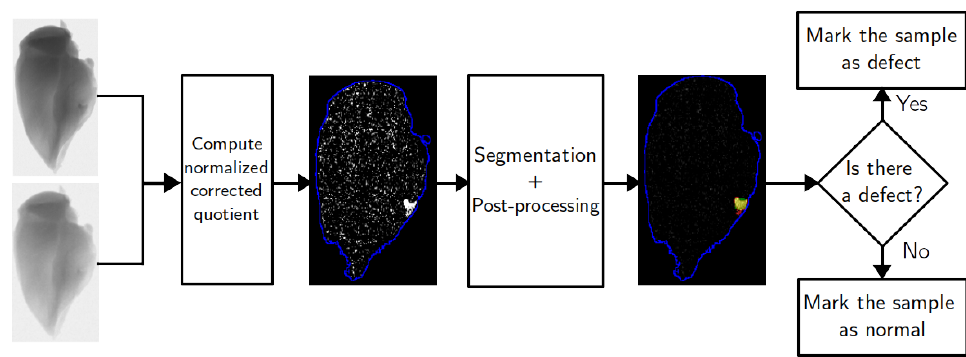
Figure 1. Diagram of the foreign object inspection procedure. The input is two projections of the sample acquired with different voltages of the tube. The blue curve on the images approximately shows the sample boundary. The segmentation image uses green color for pixels that were incorrectly classified as a defect, red for not detected foreign object pixels and yellow for detected pixels of the